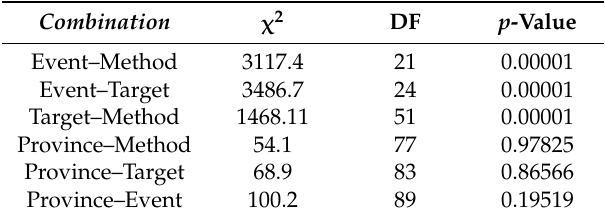
Table 5. Chi-squared test of independence on attribute combinations; Combination =